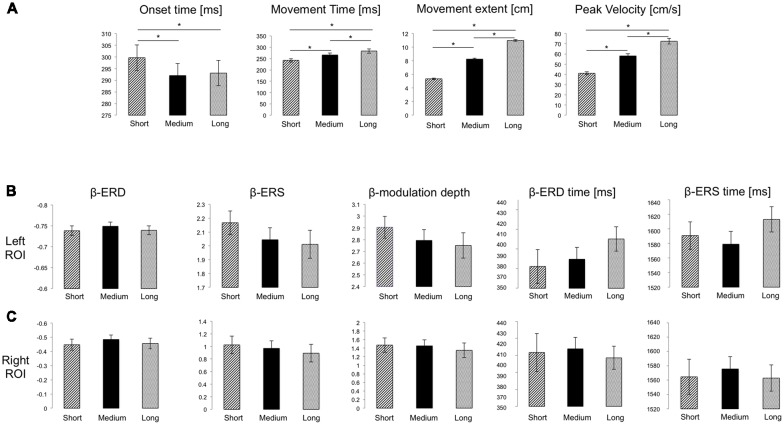
(A) Mean and SE of performance measures for the three target distances. Significant Bonferroni-corrected post hoc pairwise comparisons (p < 0.05) are marked with *. (B,C) Mean and SE of the magnitude of beta event-related desynchronization (ERD), event-relatedsynchronization (ERS) and modulation depth (dimensionless), as well as of ERD and ERS timing for the Left and Right ROIs, respectively. No significant differences were found.